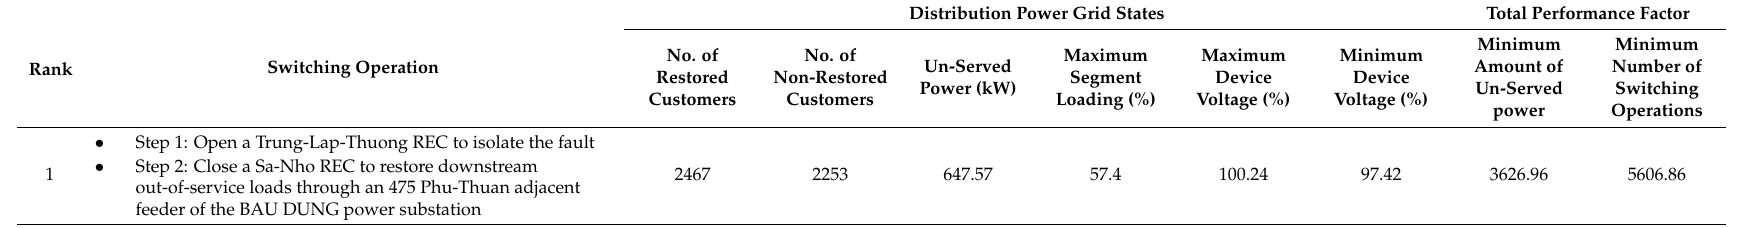
Table 17. Possible isolation and service restoration (ISR) plans based on two proposed constraints (with the DPGF at F2).